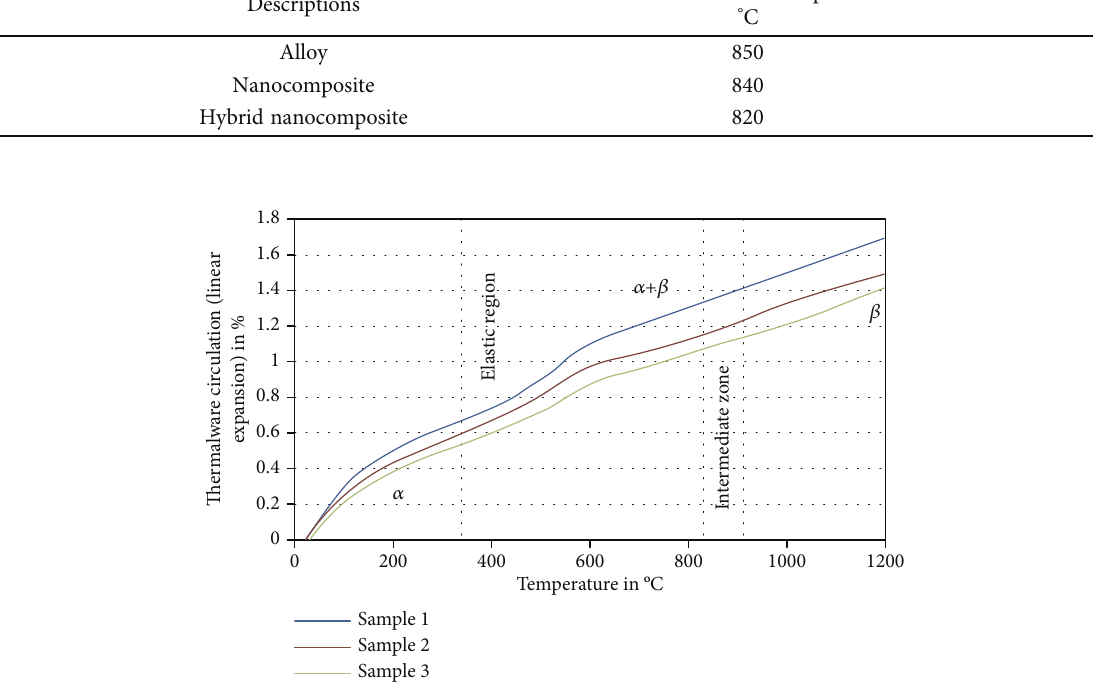
Table 5: Intermediate transition zone for unreinforced and reinforced silver matrix composite by di ff erential thermal analysis. Sample